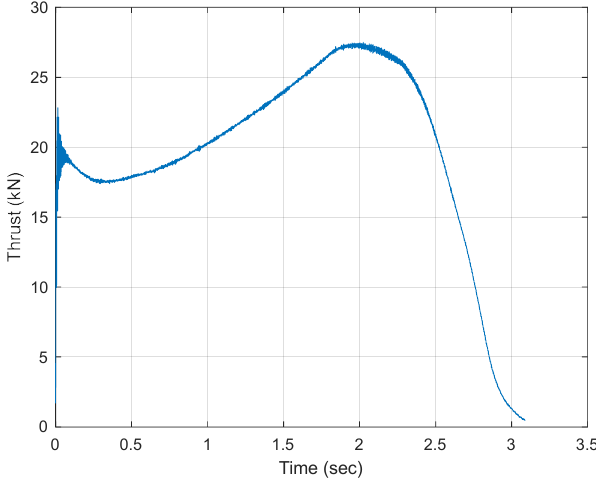
Figure 4. Rocket Motor Thrust-Time Curve at Sea Level.